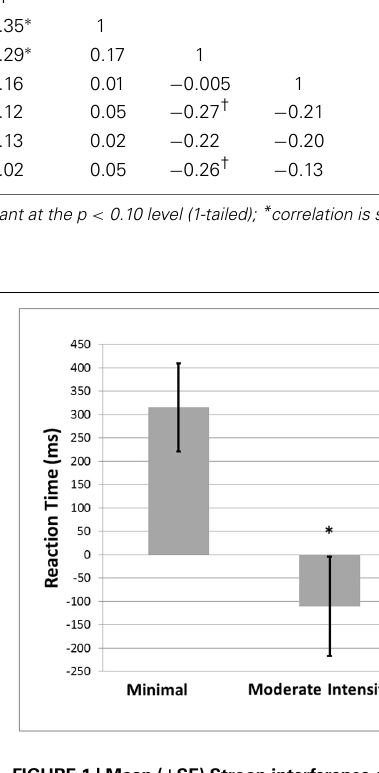
FIGURE 1 | Mean ( ± SE) Stroop interference effect (incongruent RT-congruent RT) as a function of exercise condition. ∗ Significantly different from the minimal exercise condition at the p < 0 . 05 level